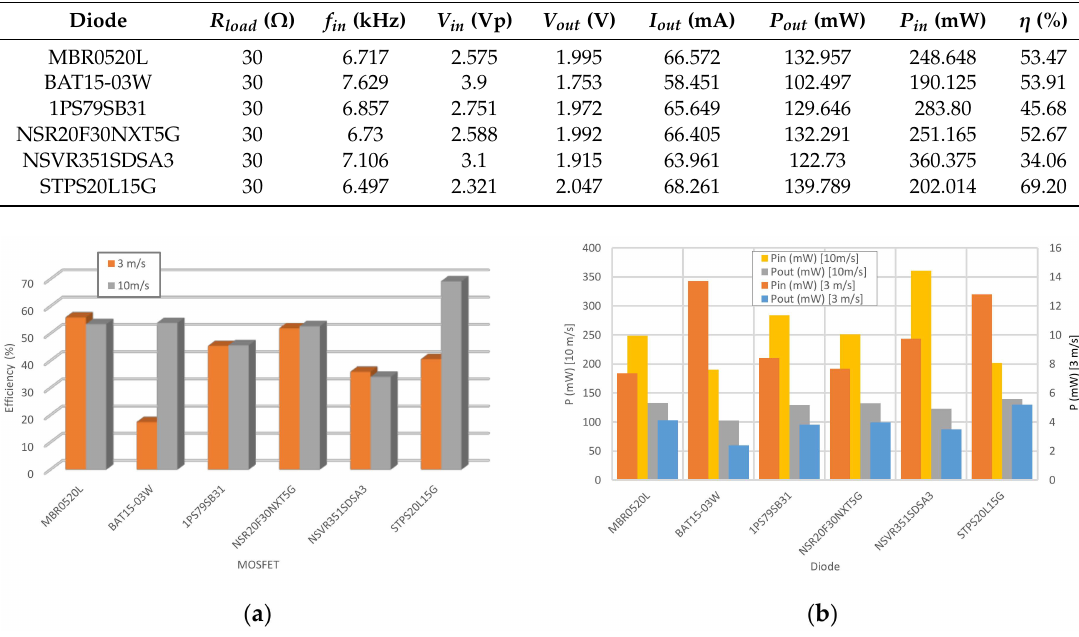
Table 18. Comparative results between di ff erent diodes at 10 m / s.